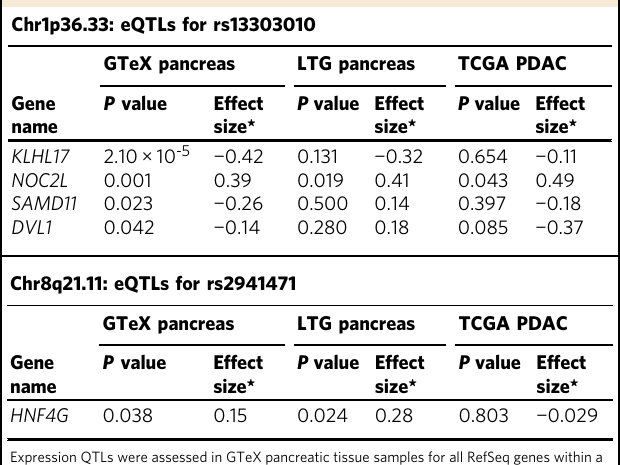
Table 2 Expression quantitative trait loci (eQTLs) for marker SNPs on chromosomes 1p36.33 and 8q21.11 in histologically normal pancreatic tissue samples from GTeX ( n = 149) and LTG ( n = 95) as well as pancreatic tumor samples from TCGA (PDAC, n =